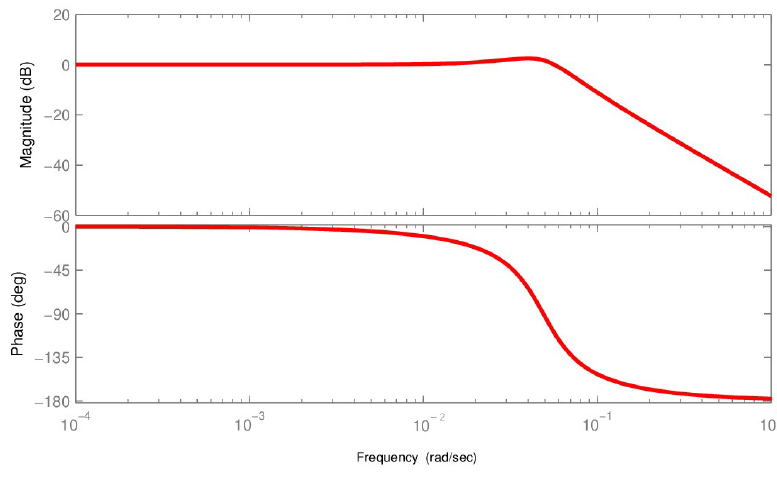
Figure 1. Bode plot of ∆ p in and ∆ p out in Equation